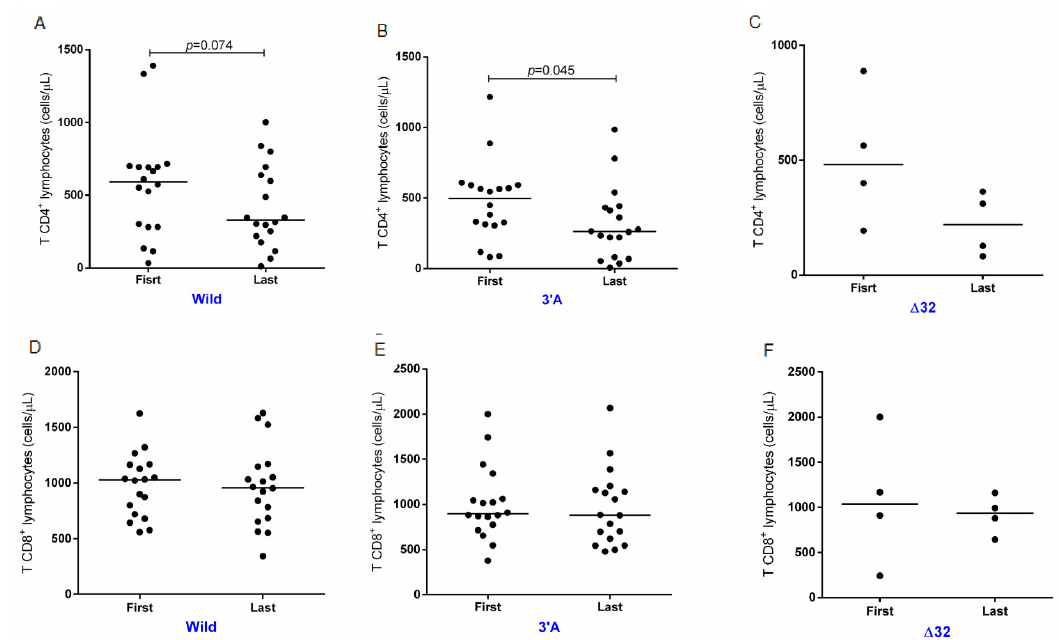
Figure 4. Longitudinal evolution of LT CD4+ and LT CD8+ counts in individuals with HIV-1 carrying the wild-type genotype and variants for SDF1-3 (cid:48) A and CCR5 ∆ 32. CD4+ LT quantifications of carriers ( A ) of the wild-type genotypes, ( B ) of the SDF1-3 (cid:48) A variant and ( C ) CCR5 ∆ 32. CD8+ LT quantifica-